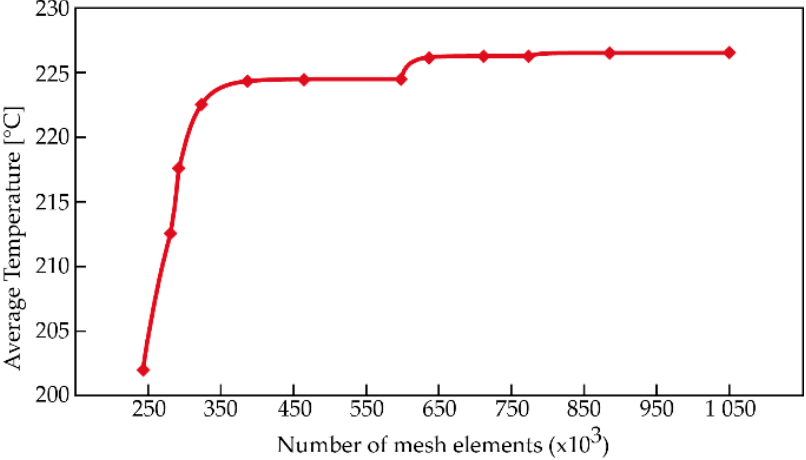
Figure 6. Results of the grid-independent study.